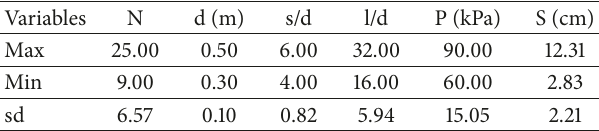
Table 1: Statistical analysis for the input and output parameters of the simulation